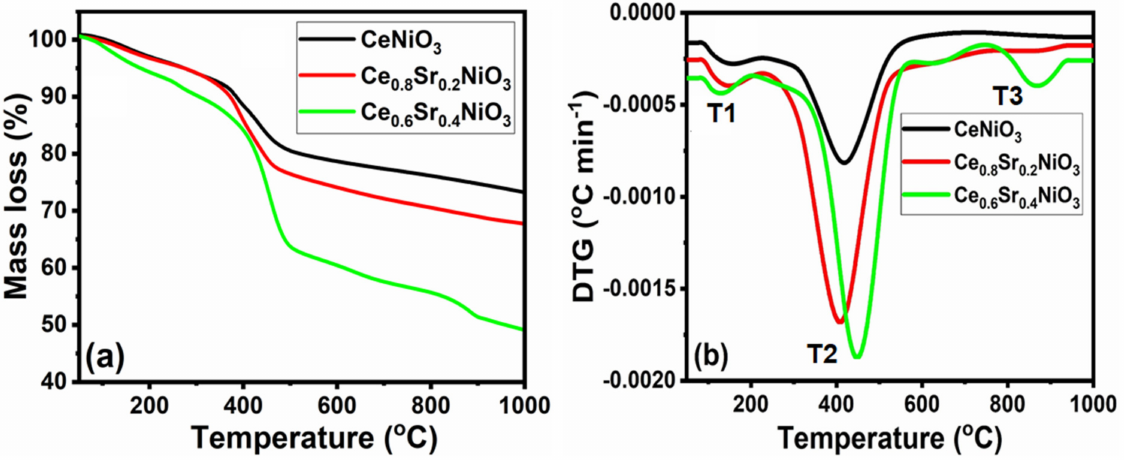
Figure 1. TG − DTG curves versus temperature of Ce x Sr 1 − x NiO 3 (x = 0.6–1)